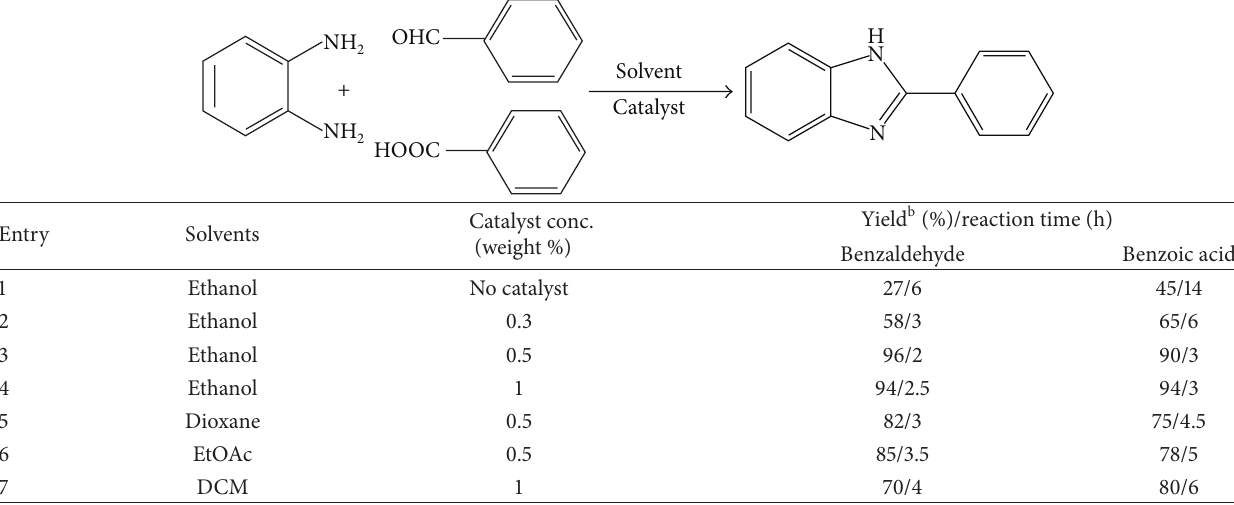
Table 1: Optimization of reaction conditions a for synthesis of substituted benzimidazoles from benzaldehyde/benzoic acid with o - phenylenediamine.